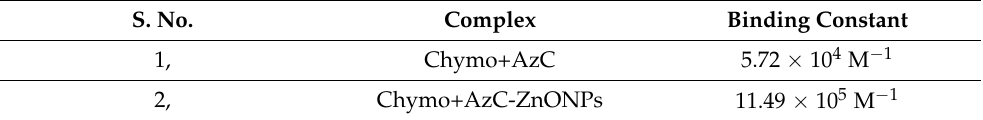
Table 1. Variation in binding constant of Chymo with AzC and AzC-ZnONPs complex. S.